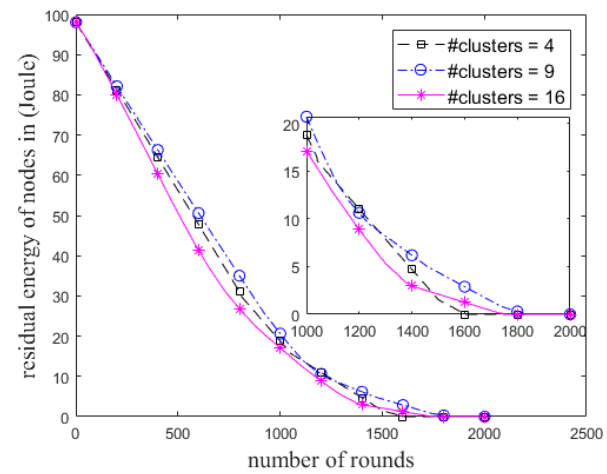
Figure 7. Total residual energy of the nodes in each round in ECCR.